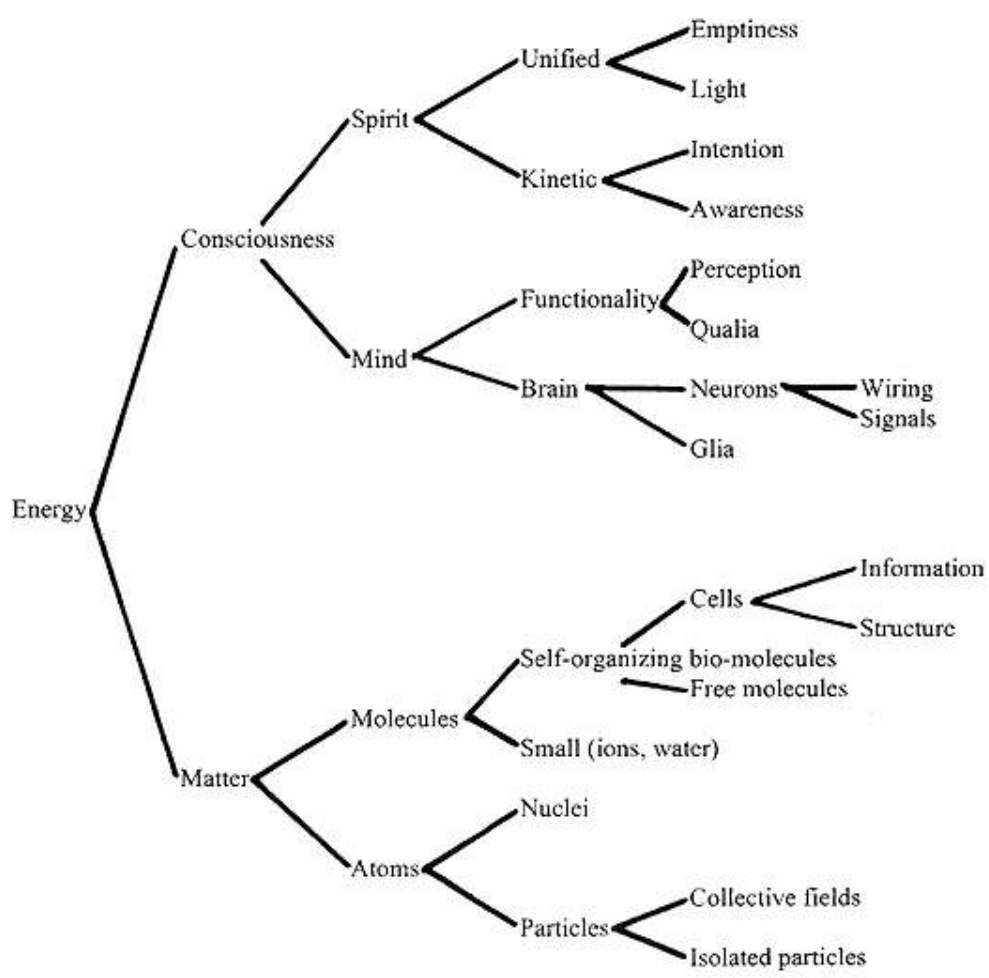
FIGURE 3. A fractal ontology with the bifurcation number 2. Except for the first lines, the concepts invited by this ontology are very much like the concept used by contemporary natural science. It seems that science, through time, developed towards acknowledging and integrating the concepts in the upper part of the